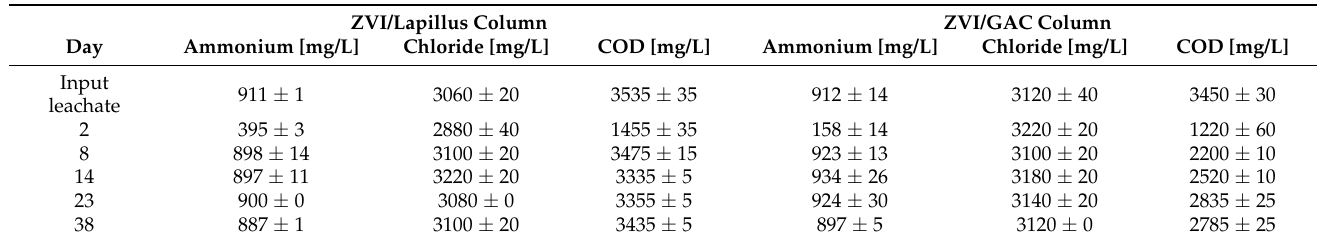
Table 4. Ammonium, chloride, and COD concentrations in MLLs coming from ZVI/lapillus and ZVI/GAC columns. ZVI/Lapillus